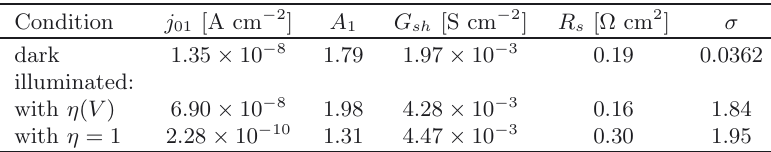
Table 1. Diode parameters by the proposed procedures for dark and illuminated curves of a typical Cu(In,Ga)Se 2 solar cell. In addition the influence of a voltage-dependent and -independent ( η = 1) photo current density is compared during the suns- V oc analysis. The standard deviation σ is always calculated by a numerical solution of equation